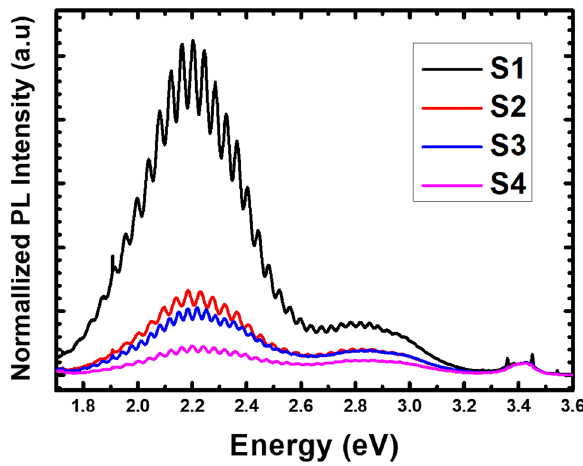
Figure 10. RT-PL spectra for samples S1, S2, S3 and